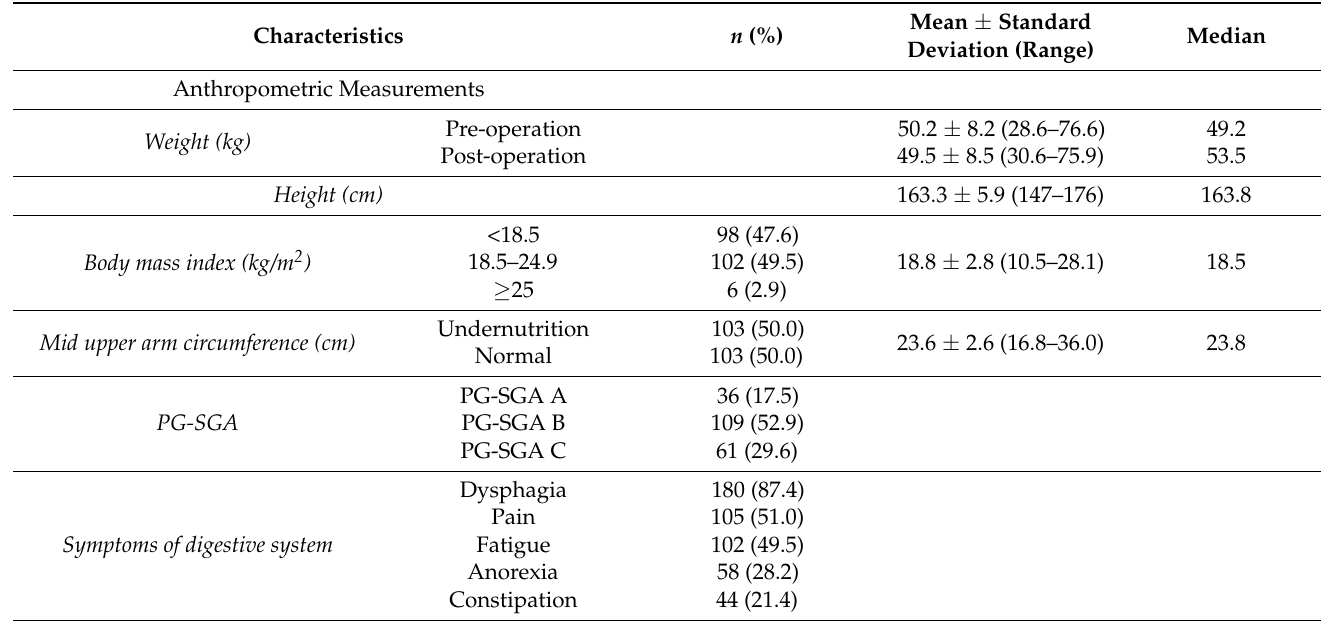
Table 2. Characteristics on anthropometric measurements, Patient-Generated Subjective Global Assessment (PG-SGA), weight change, symptoms of digestive system, and biochemical